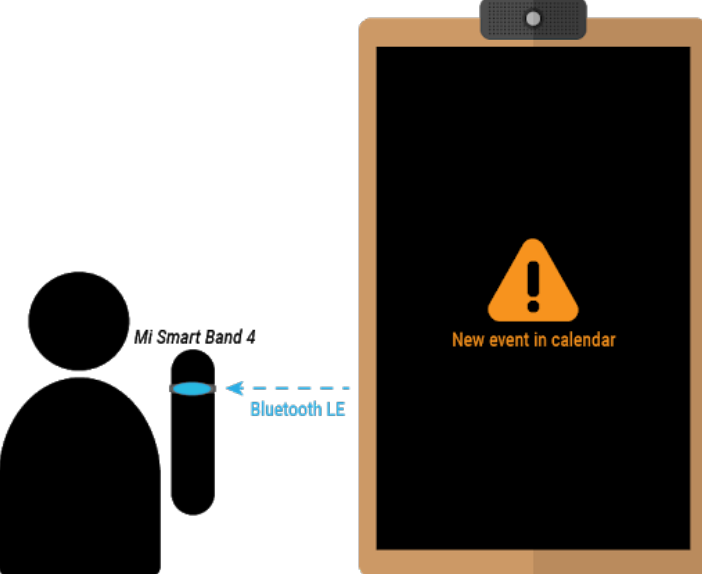
Figure 16. Reminders sent to the Mi Band 4 smart